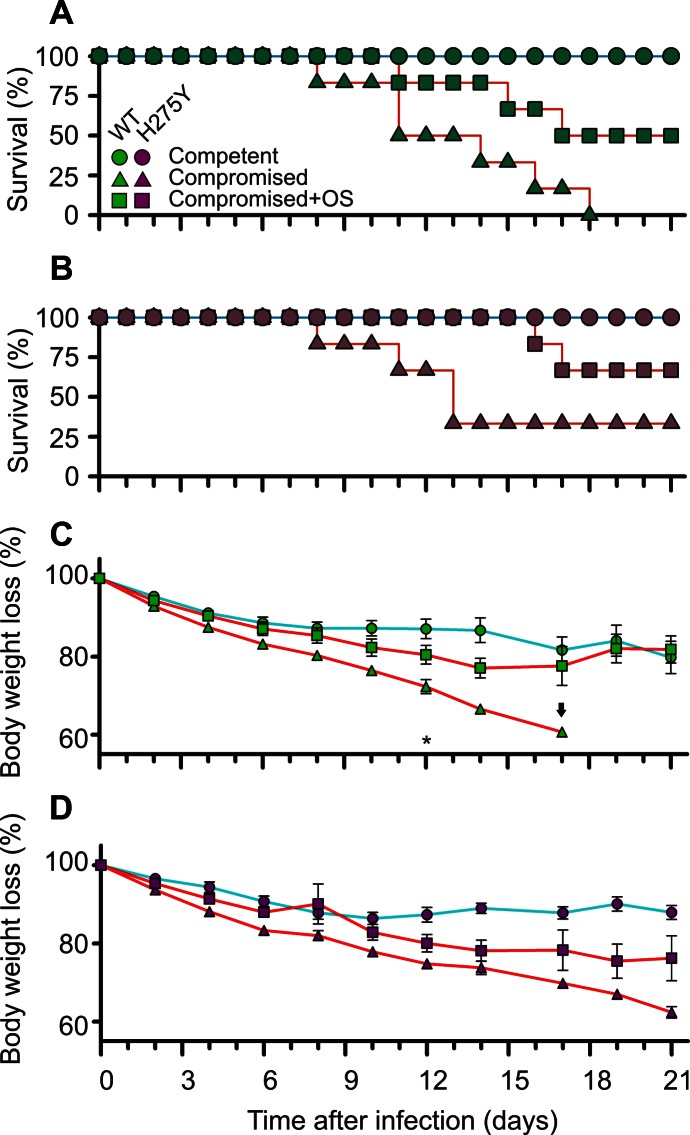
Increased survival and reduced loss of body weights of immunocompromised ferrets treated with oseltamivir.Kaplan-Meier survival curves for groups of immunocompetent ferrets (circles), immunocompromised ferrets (triangles) and immunocompromised ferrets treated with oseltamivir (squares) (a;b). Groups of ferrets were infected with wild type (green;a;c) or oseltamivir resistant (H275Y) mutant virus (magenta;b;d). Body weights are displayed from day 0 to day 21, with a two or three days interval (c;d). Data points represent mean ± s.e.m. of percentage body weight loss. Body weights at day 0 were set at 100%. The arrow indicates data point of only a single animal. The asterisk indicates significant difference between untreated and oseltamivir treated immunocompromised animals (P = 0.03). The P value was calculated by a two-tailed Mann-Whitney U test, when at least 3 animals were present in each group.